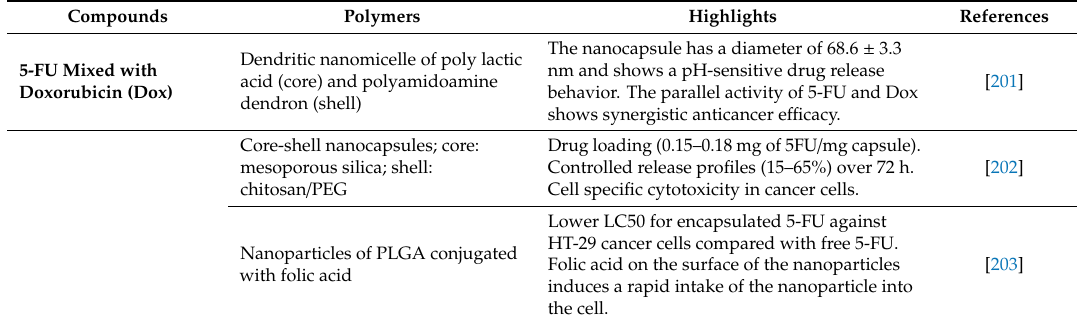
Table 4. Recent advances in using 5-fluorouracil (5-FU) and its derivatives in polymer encapsulation strategies for